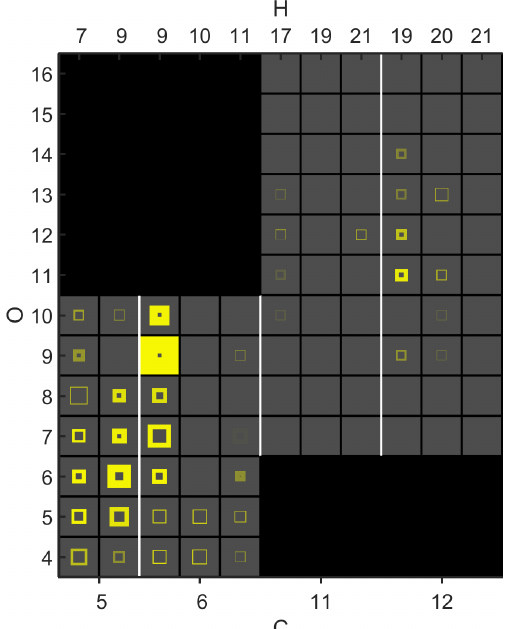
Figure 4. Signal changes in N-containing molecules upon NO x ad- dition during cyclohexene ozonolysis. The axes and transparency follow the same logic as in Fig. 5. The areas of the yellow squares show the size of the signal under high NO x (9ppb) conditions. The “holes” in the square correspond to the size of the background sig- nal, i.e. the signal before NO x